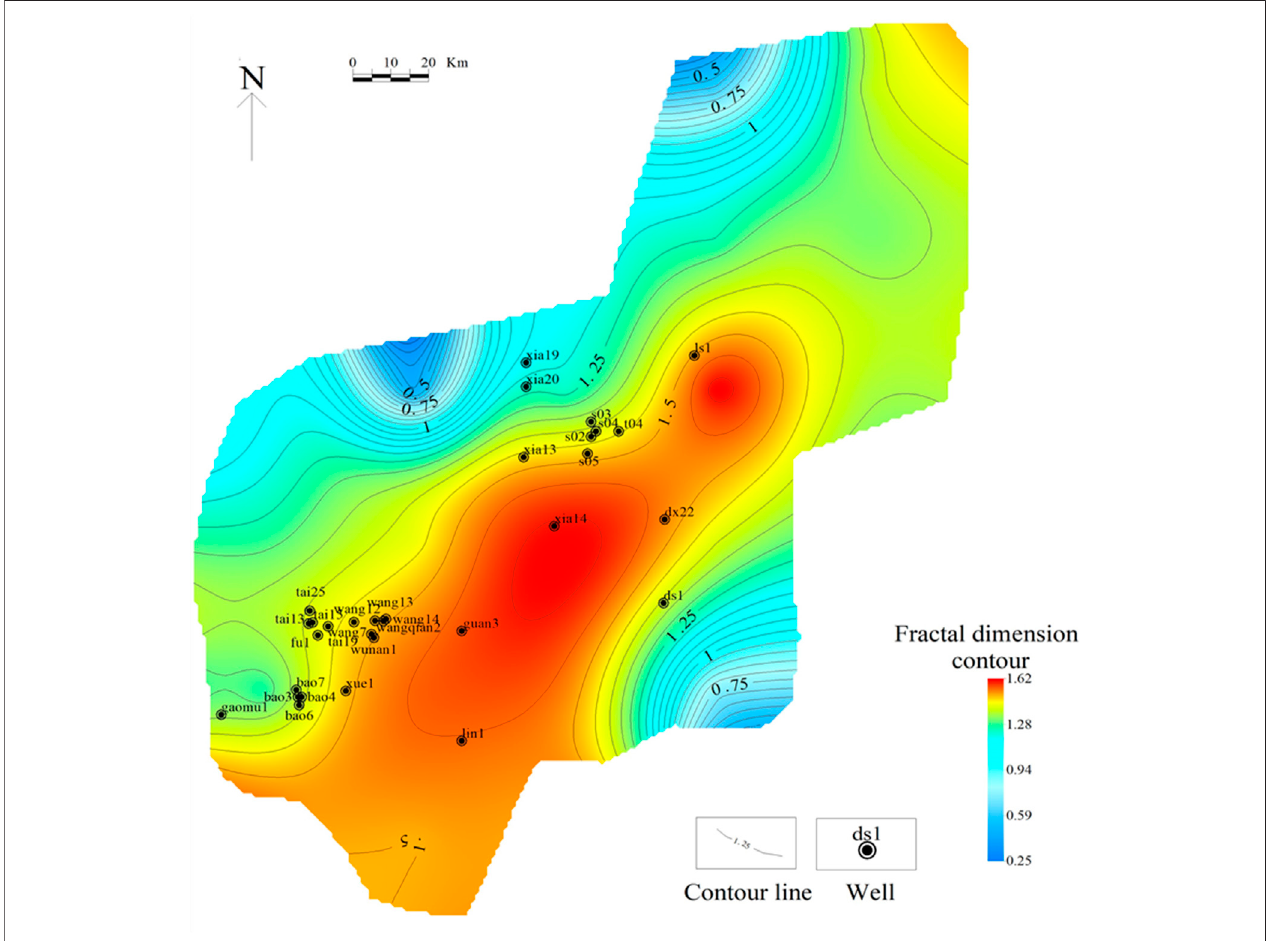
FIGURE 5 | Contour map of fractal dimensions of faults in Maokou Formation in southeast Sichuan (q = 0)